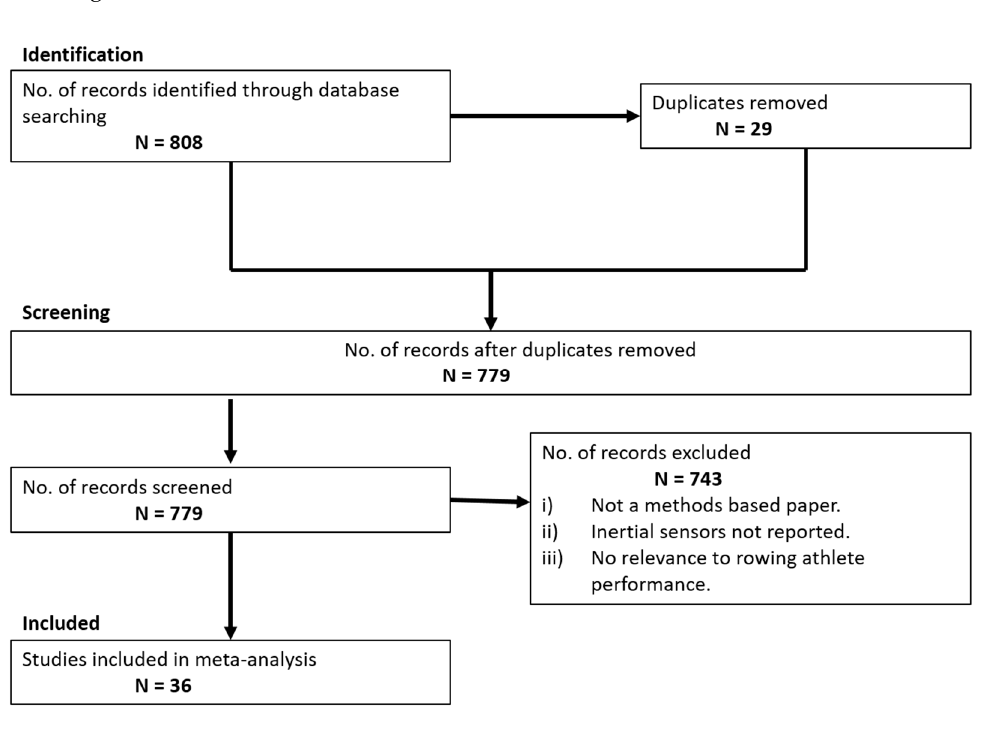
Figure 1. Flow diagram of study selection.